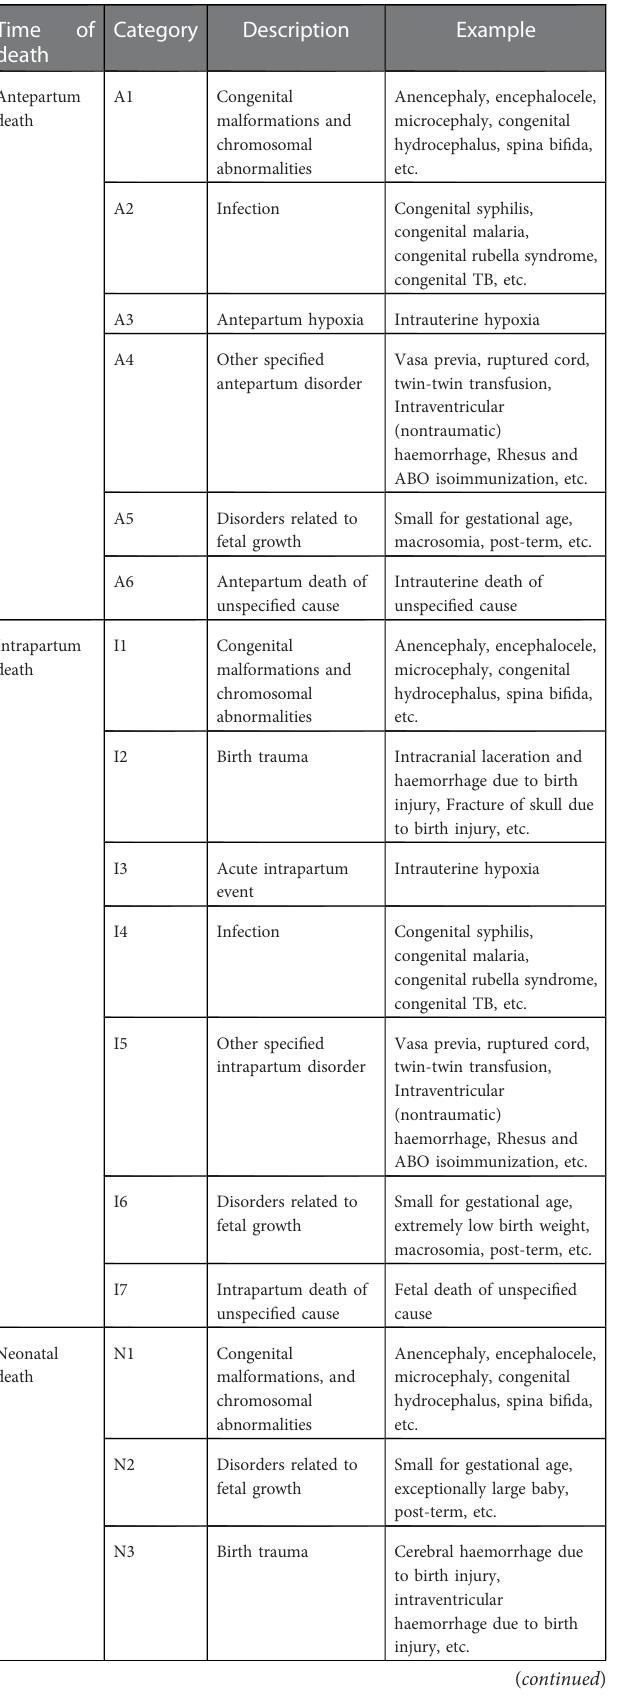
TABLE 1 ICD-PM categories with the speci fi c cause of perinatal death and maternal health condition.